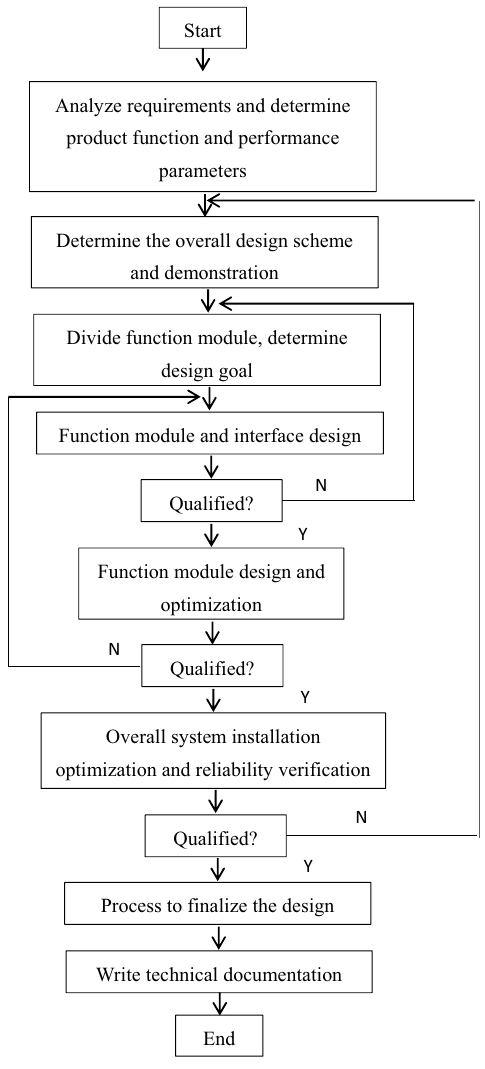
Figure 2: Typical mechanical and electrical product design